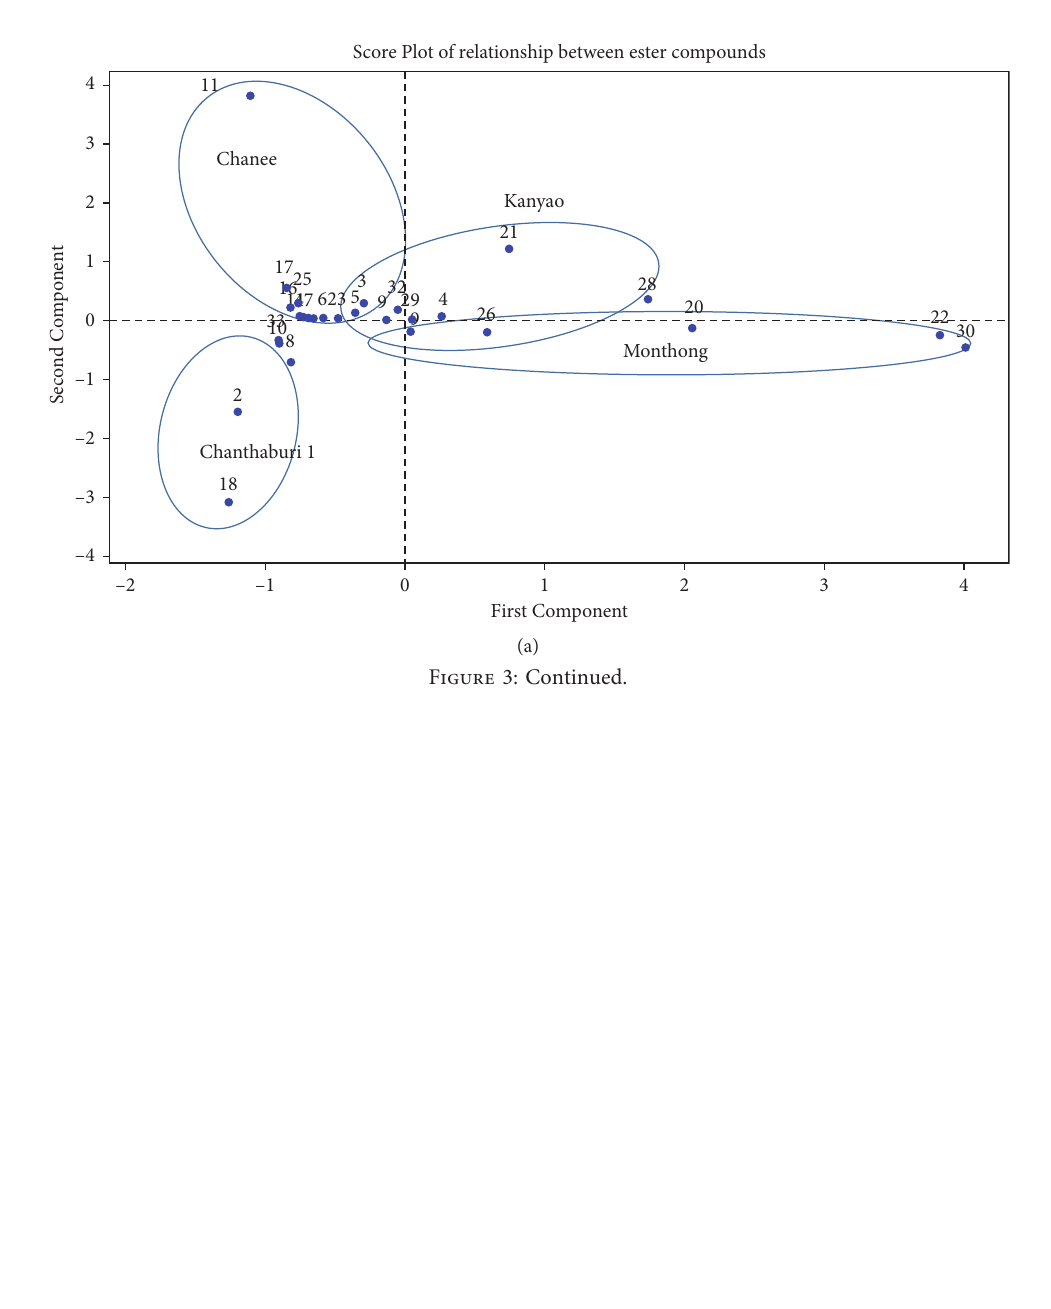
Figure 2: Dendrogram of the relationship in the ester compound produced in 4 Thai durian cultivars (1 � “Chanthaburi 1,” 2 � “Chanee,” 3 � “Monthong,” and 4 �